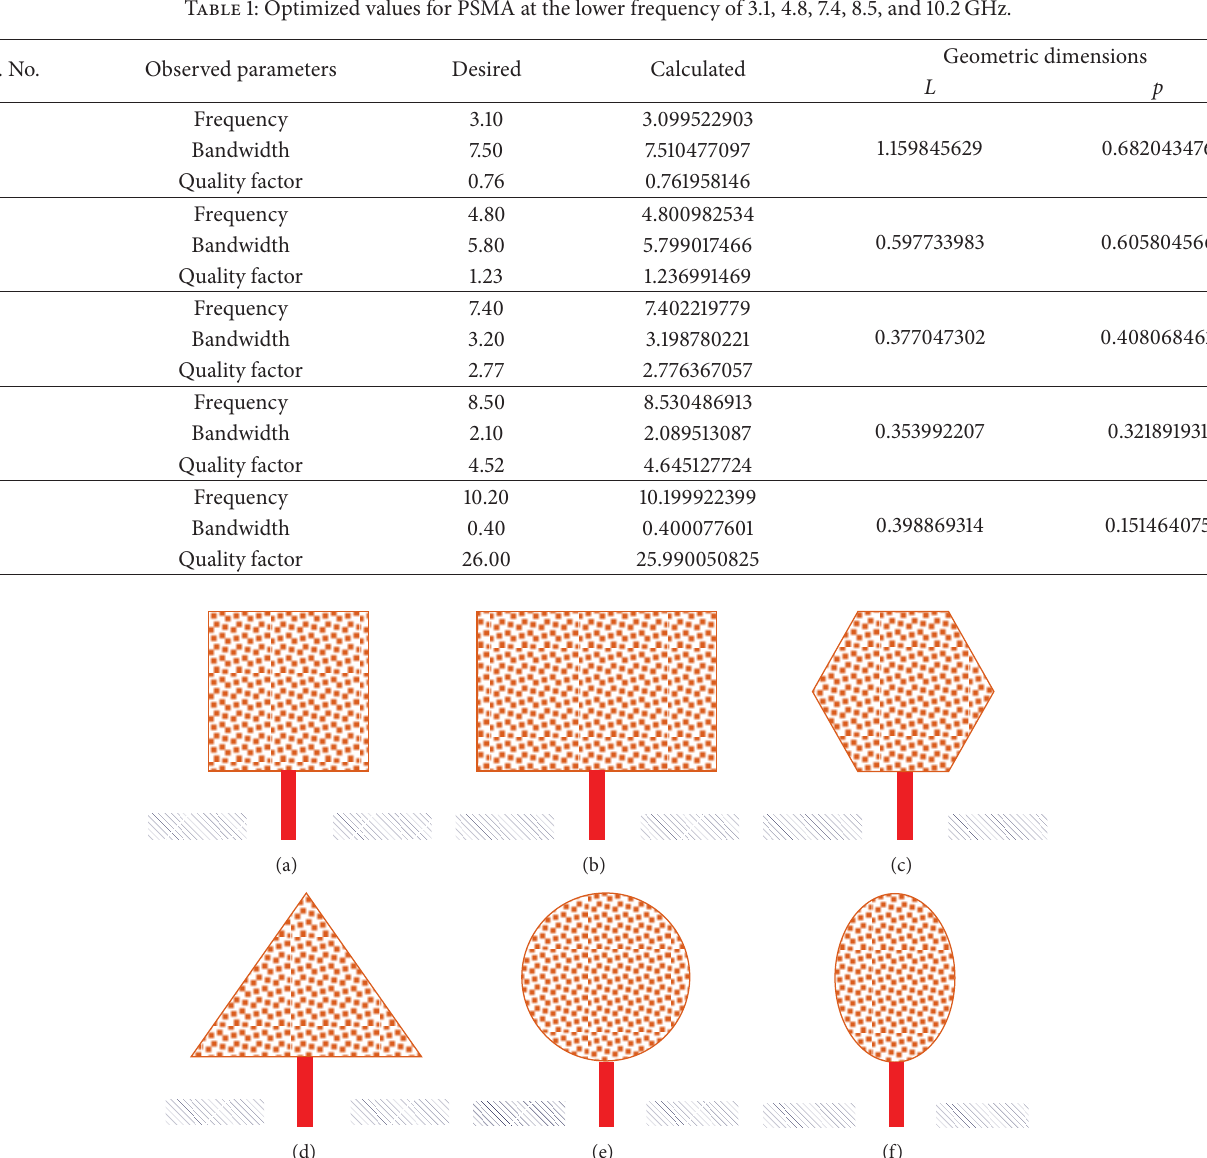
Figure 1: Printed (a) square, (b) rectangular, (c) hexagonal, (d) triangular, (e) circular, and (f) elliptical monopole